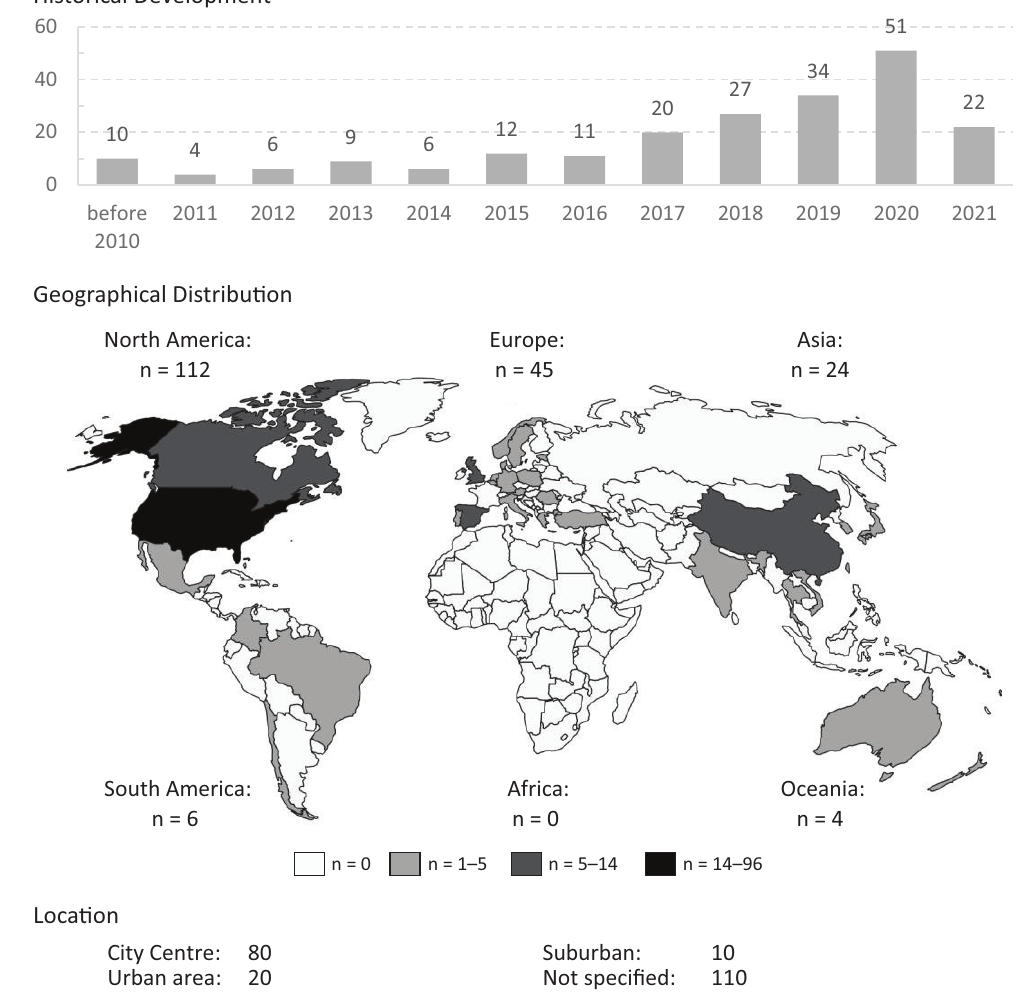
Figure 2. Article characteristics from the selected articles.